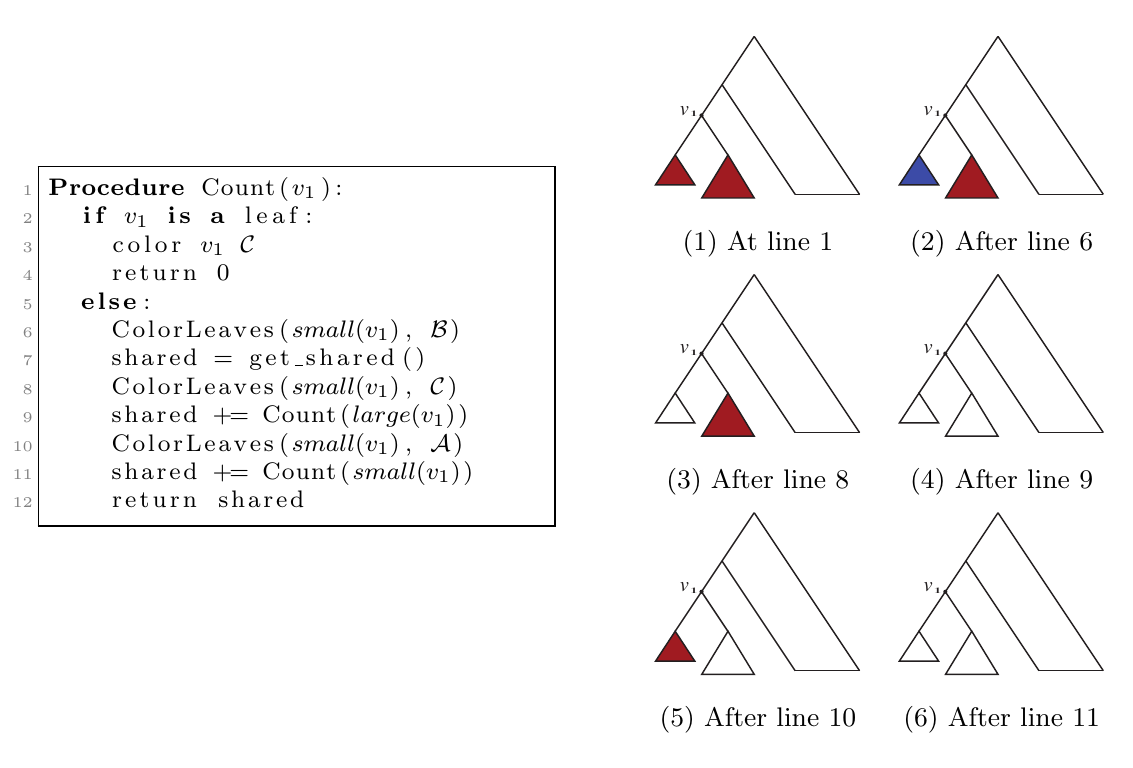
Figure 4. Traversing T using the “smaller-half trick” to ensure that each leaf changes color 1 at most O (log n )